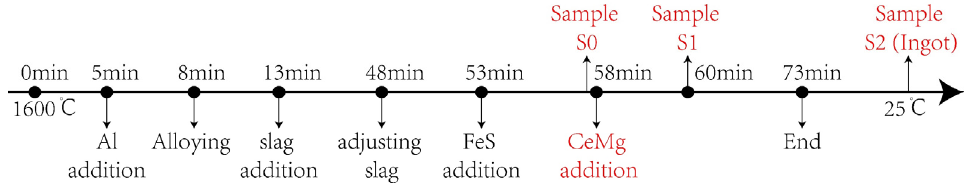
Figure 2. Experimental process.